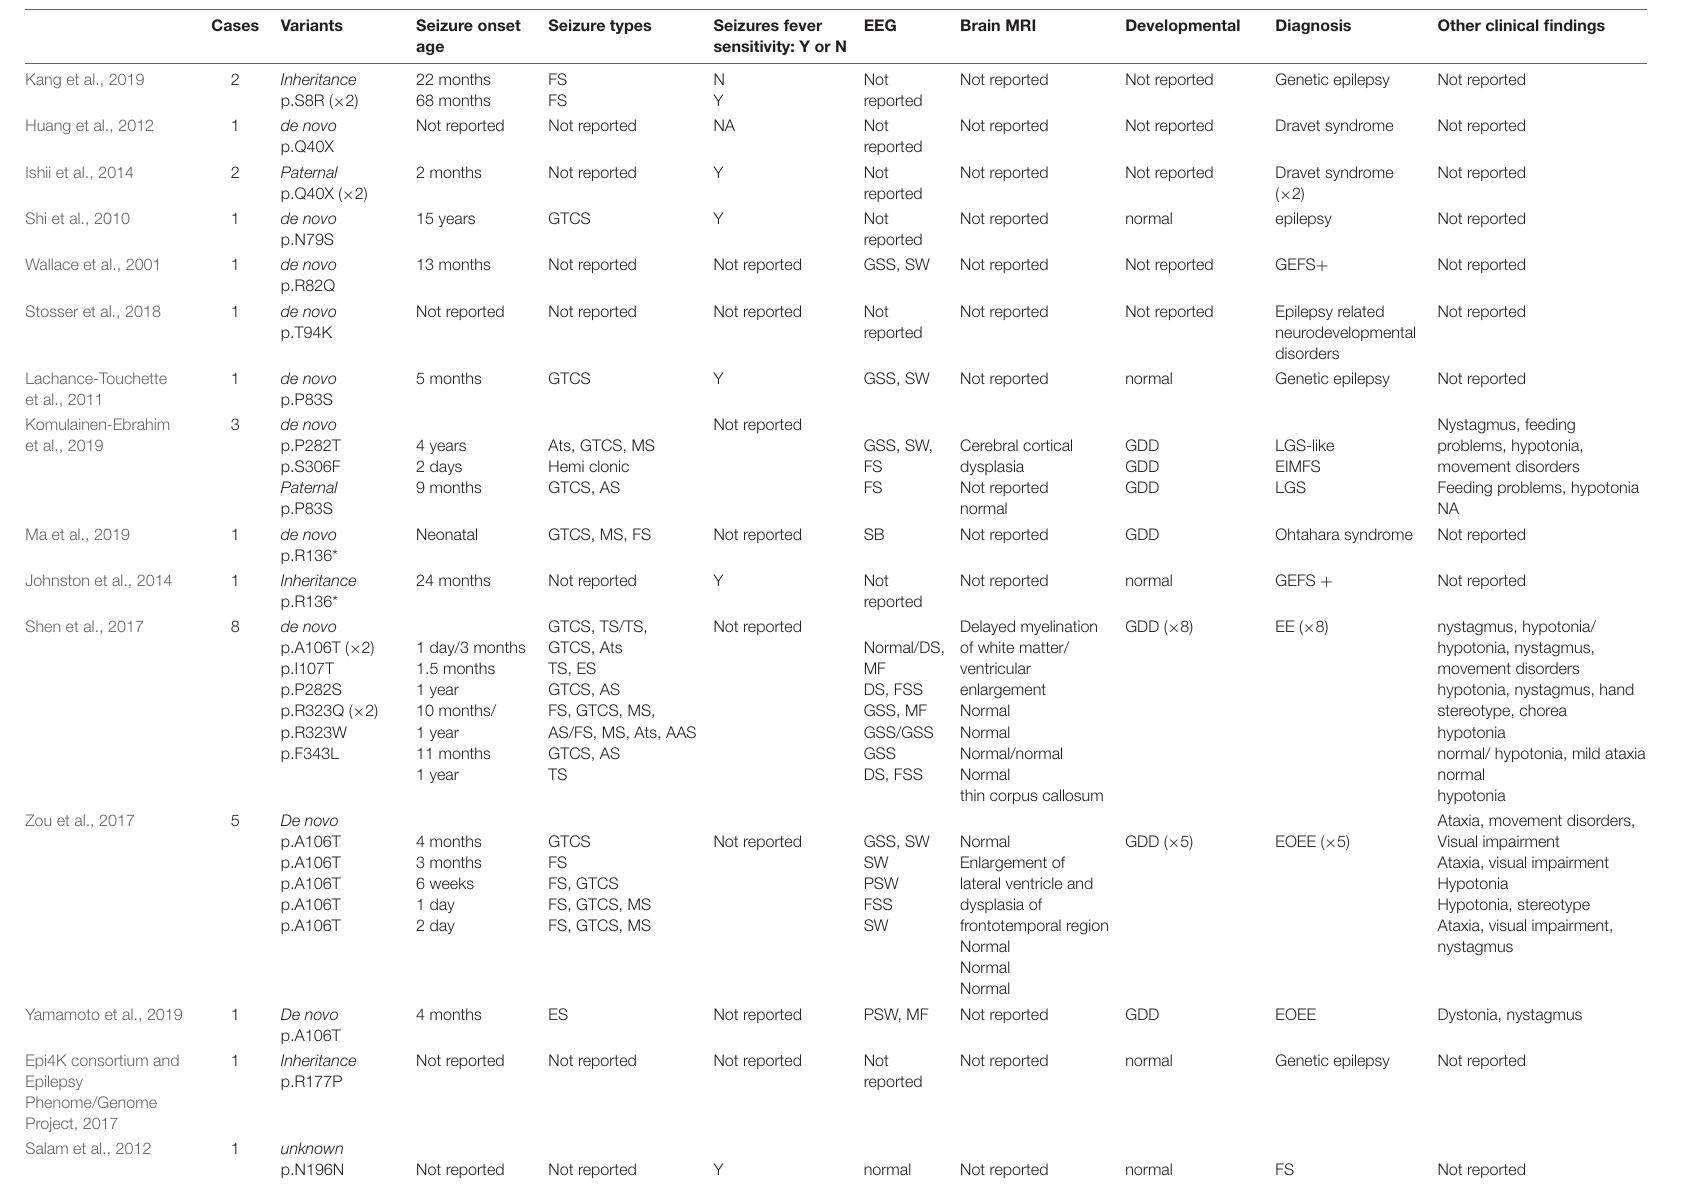
TABLE 2 | The genotype and phenotype of 58 patients reported in literature with GABRG2 variants related to